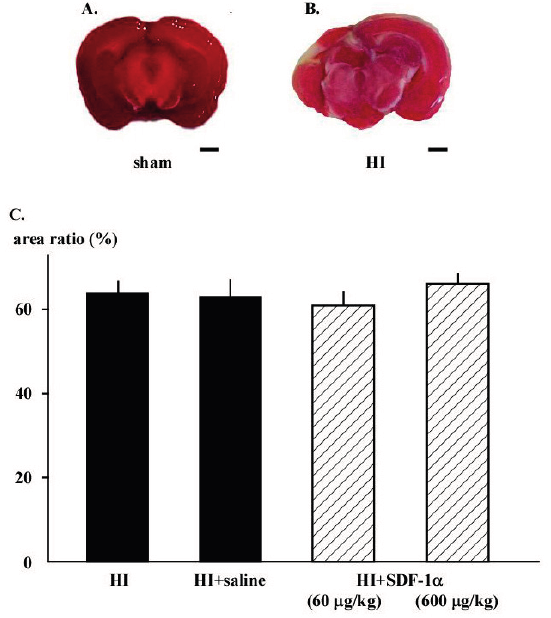
Figure 3. Rotarod test results demonstrating that motor coordination was disturbed in rats in the HI group. Fall-down time was decreased in the HI group compared to the sham group (* p < 0.05) and not affected by SDF-1 α treatment.